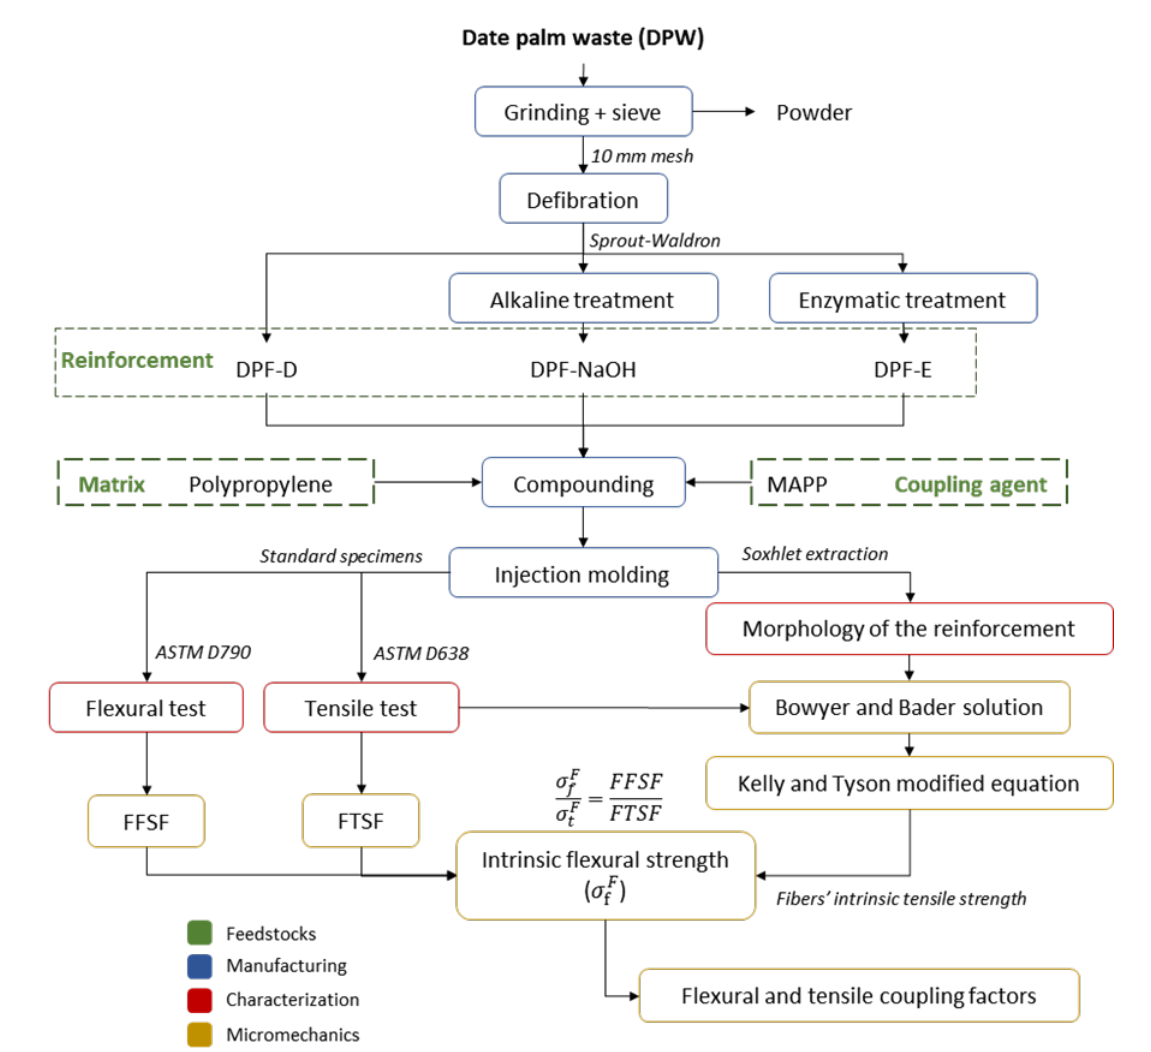
Figure 3. Workflow of the present investigation.